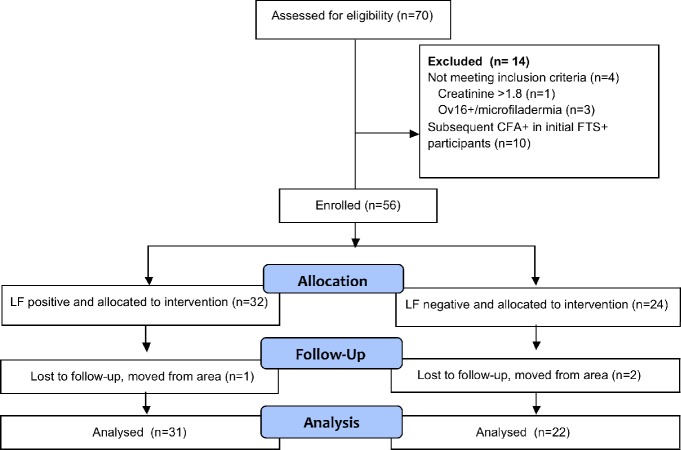
Screening, enrollment, PK study, and one-year follow-up to assess drug efficacy.